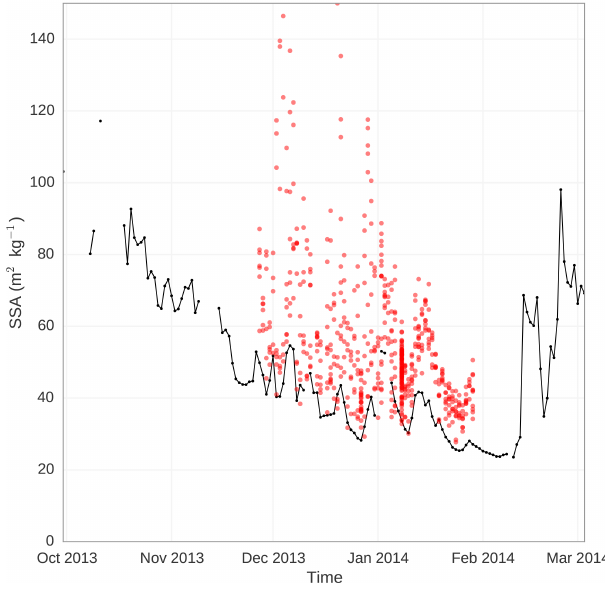
Figure 15. Time series of daily mean SSA averaged for the two heads of Autosolexs (black line) and manual measurements taken using ASSSAP (red dots). Both instruments have different vertical sensitivity as illustrated in Fig.